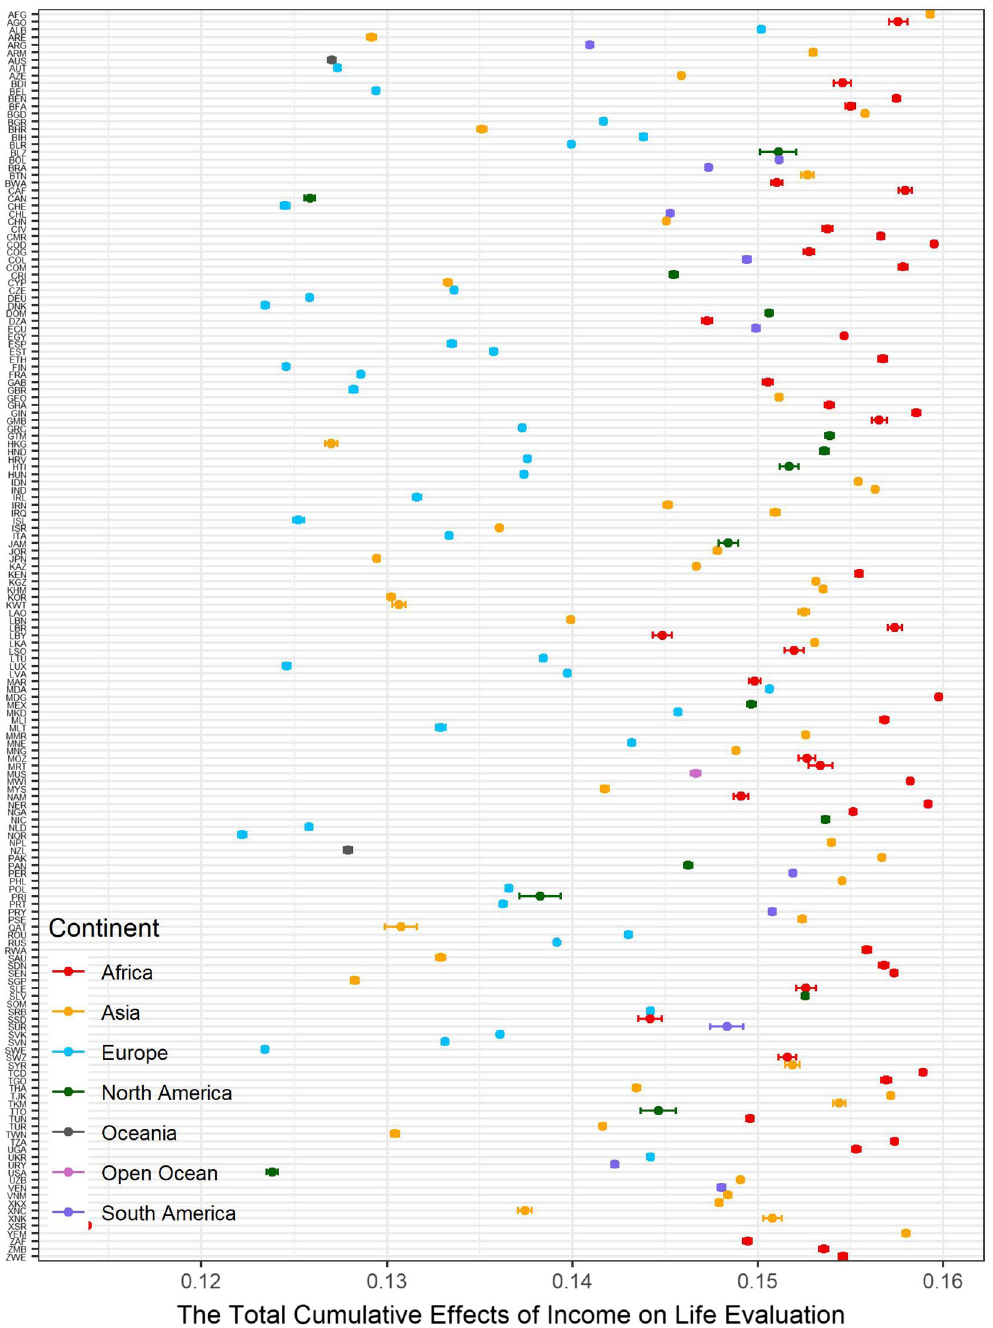
Figure 8. The summary of total cumulative effects of income on life evaluation by